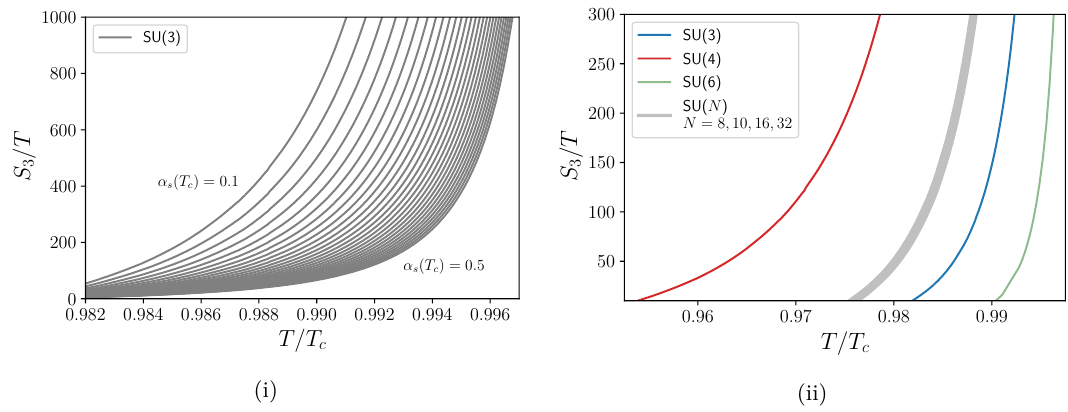
Figure 5. The action for the bounce solution as a function of temperature (i) in the case of SU(3) for different choices of α s ( T c ) and (ii) for different numbers of colors . For N ≥ 8 , the model saturates to the curve shown in gray, expected from eqs. (3.8) and (3.9) as explained in the text.